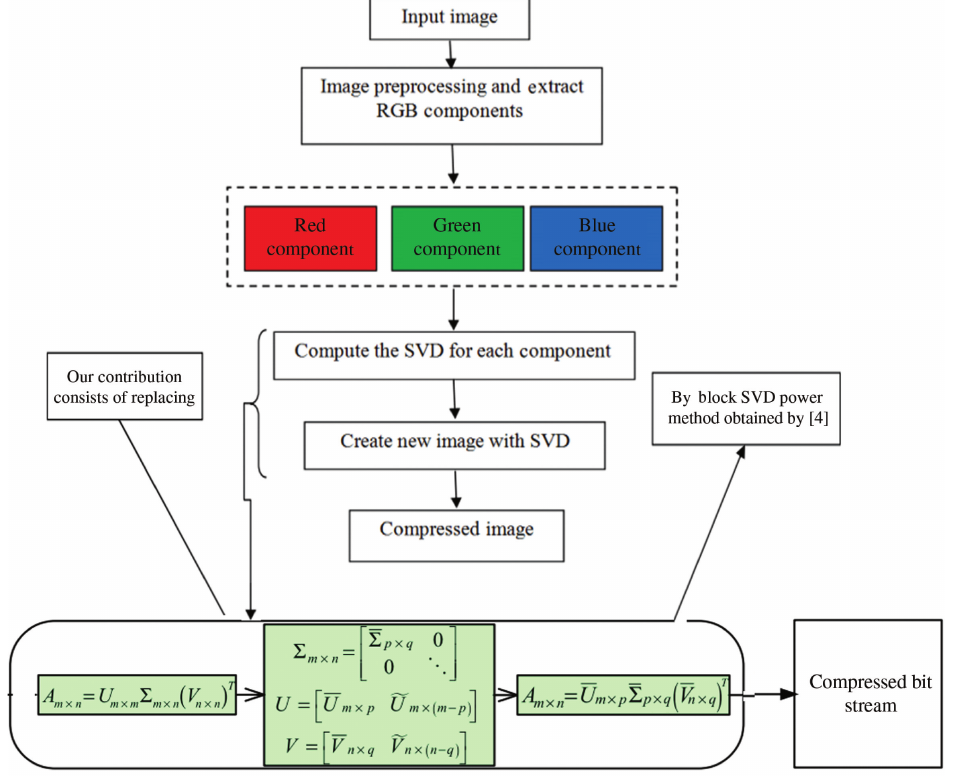
Figure 2: Color Image Pre-processing Using